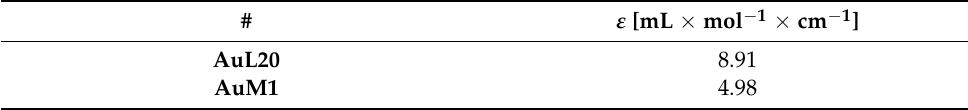
Table 2. Molar absorptivity coefficient of complexes.